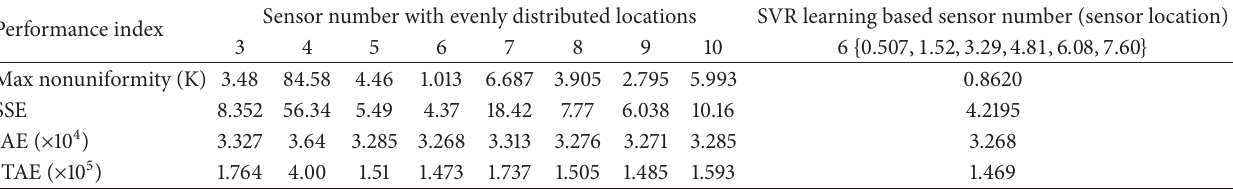
Table 2: Performance index comparisons (SVR learning based sensing locations versus evenly distributed locations). Performance index